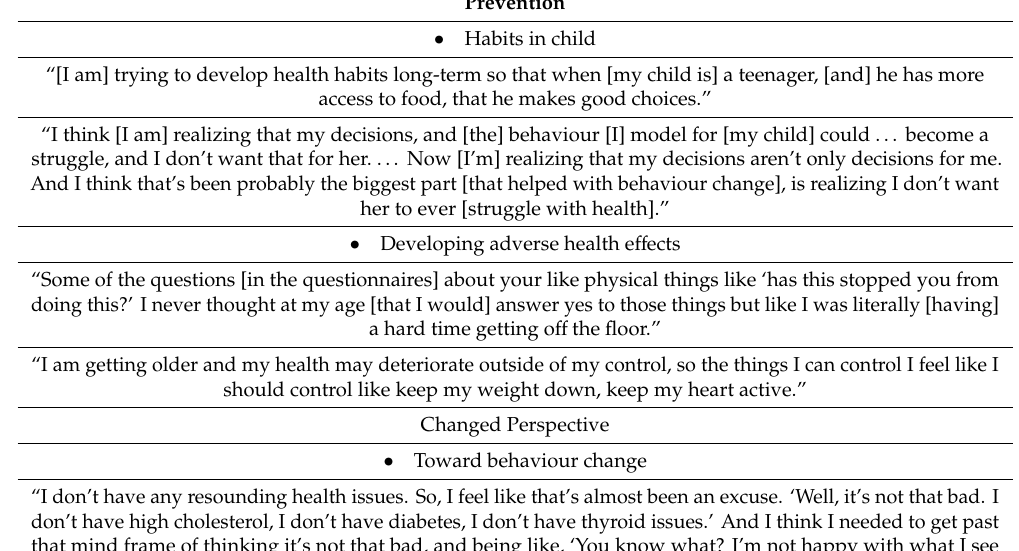
Table 12. Corroborative Quotations for 6-Month Follow-Up Themes and Sub-Themes (Control Group).